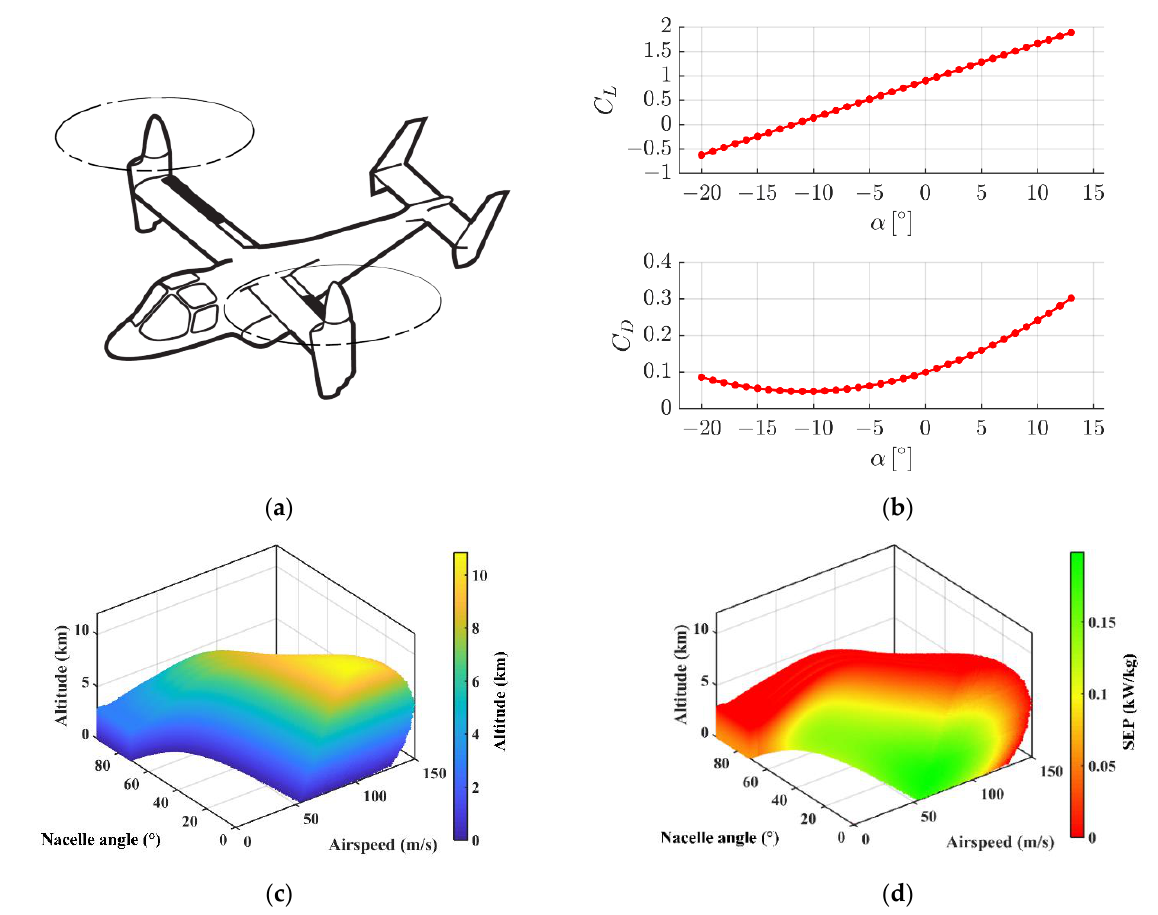
Figure 8. ( a ) XV-15 tilt-rotor aircraft; ( b ) the lift and drag coefficient curves; ( c ) the calculated 3D envelope of XV-15; and ( d ) the 3D envelope of XV-15 with SEP contour. Table 3. XV-15 key